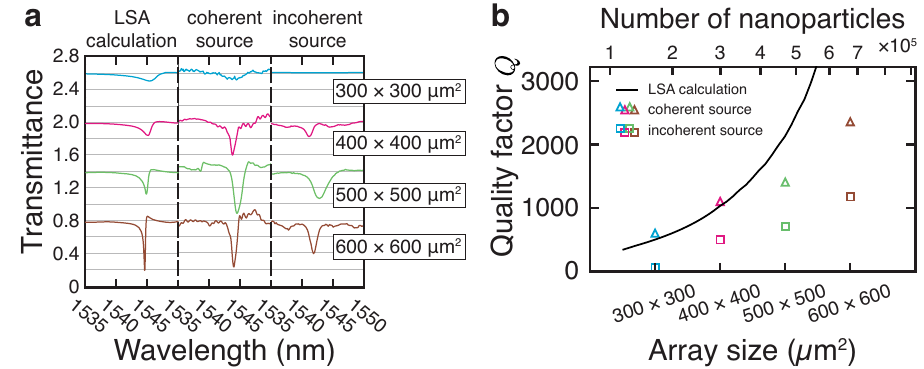
Fig. 3 Effects of array size and spatial coherence of light source. a Calculated and measured (using coherent and incoherent sources) transmission spectra for identical metasurface arrays of varying size (from top to bottom: 300 × 300, 400 × 400, 500 × 500, and 600 × 600 μ m 2 , respectively). The spectra are offset for clarity, and each vertical division corresponds to an increment of Δ T = 0.2 in transmittance. b The Q -factors extracted from Lorentzian fi ts to the calculations and to the measurements shown in a . An increase in the number of nanostructures in the array results in an increase in the estimated Q -factors. Additionally, the observed Q -factor is globally larger for each array when measured using the coherent